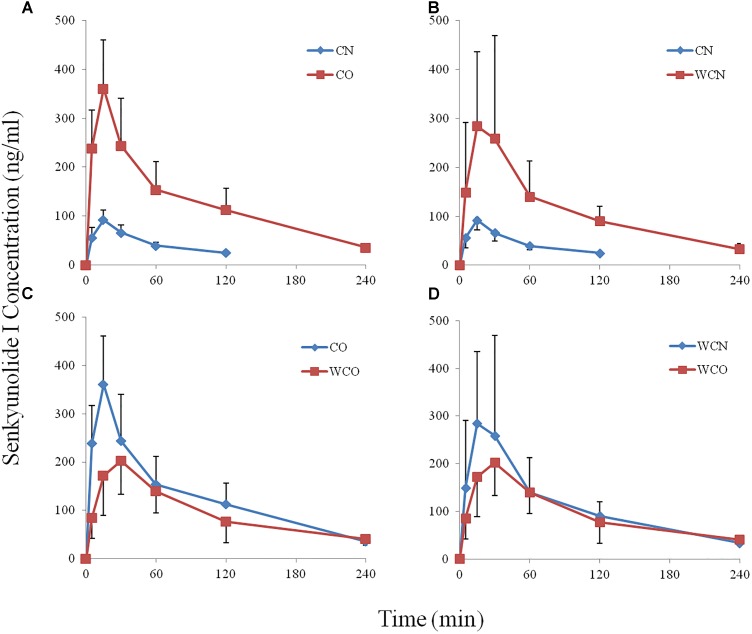
The effects of warfarin on Chuanxiong (Senkyunolide I) pharmacokinetics in rats (the mean plasma ± SD concentration-time curves for senkyunolide I, n = 8). (A) CO group compares to CN group; (B) WCN group compares to CN group; (C) WCO group compares to CO group; (D) WCO group compares to WCN group. Warfarin and biliary drainage both increase the bioavailability of Chuanxiong (Senkyunolide I) in rats. CN, healthy rats after a single administration of Chuanxiong; CO, rats with biliary drainage after a single administration of Chuanxiong; WCN, healthy rats after the administration of warfarin and Chuanxiong; WCO, rats with biliary drainage after the administration of warfarin and Chuanxiong.